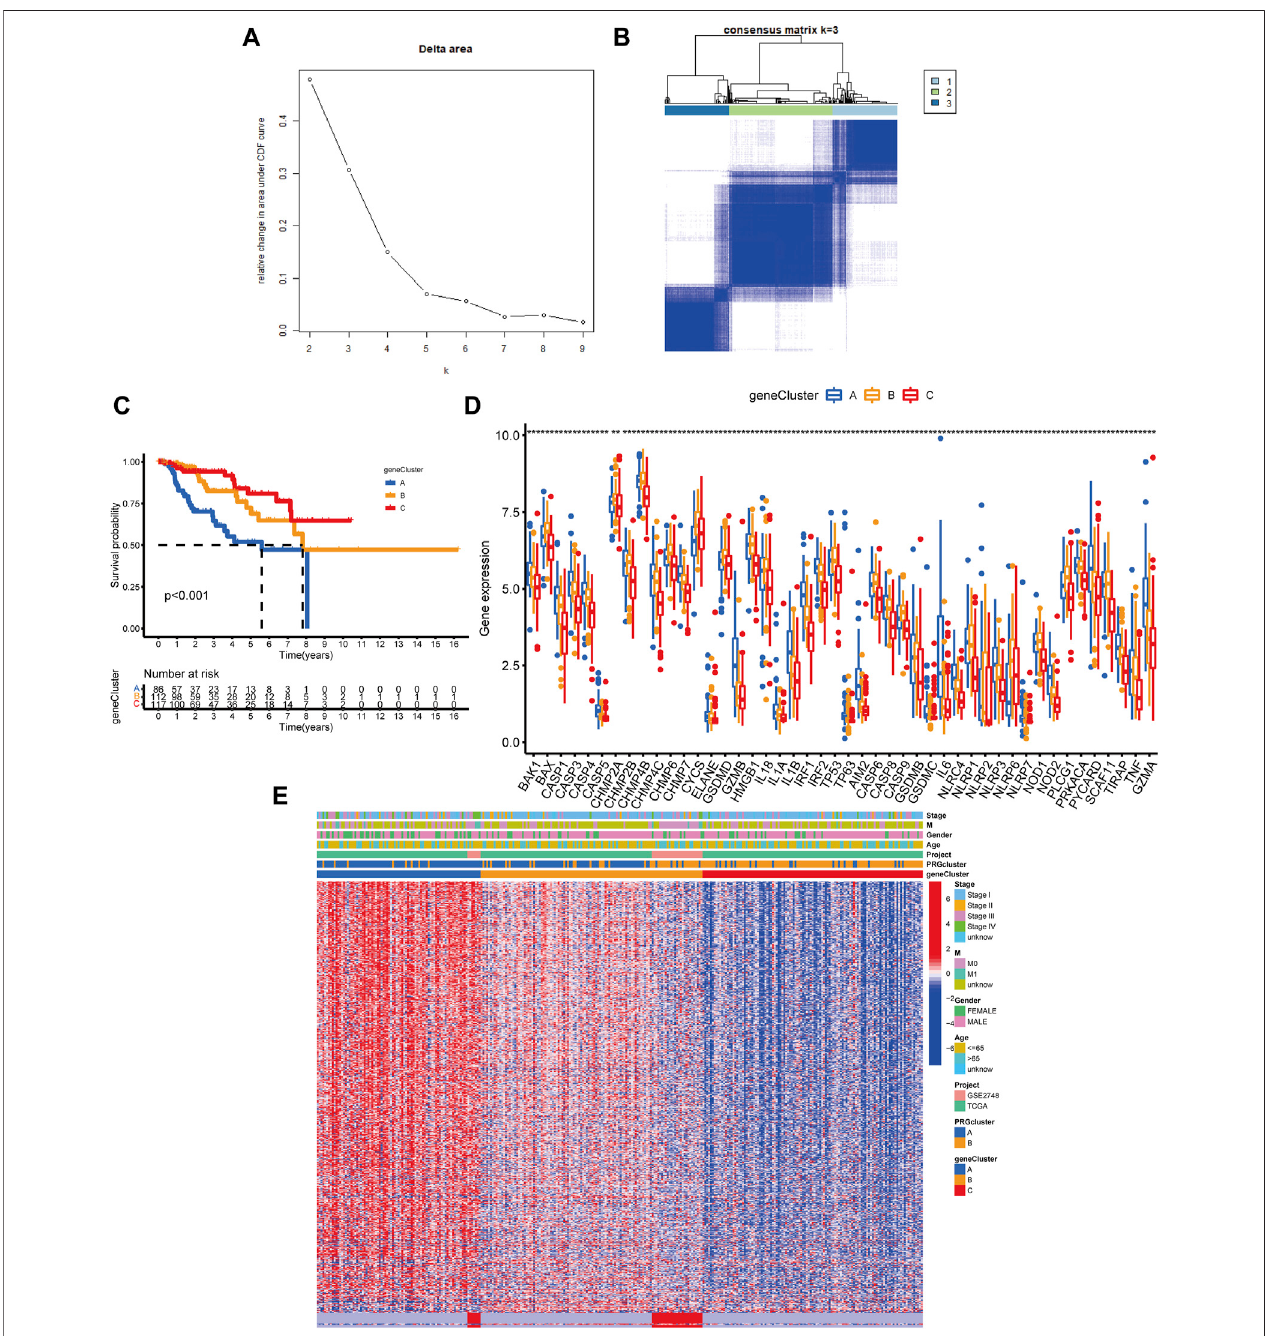
FIGURE 5 | Classi fi cation of genetic subgroups. (A) Changes in the area under the CDF curve. (B) The K = 3 consensus clustering matrix. (C) Survival curves for subgroups A, B, and C. (D) PRG expression between gene clusters. (E) Heatmap of genes based on unsupervised clustering techniques.